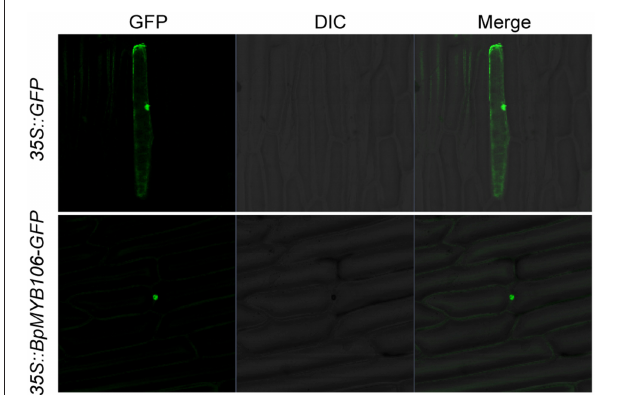
FIGURE 3 | Subcellular localization of BpMYB106. GFP and BpMYB106-GFP fusion gene under the control of the CaMV 35S promoter were expressed transiently in onion epidermal cells. Negative controls were maintained with constructs and empty vectors. GFP, fluorescence of GFP; DIC, differential interference contrast (optical microscopic image); Merge, digital merge the images of DIC and GFP.